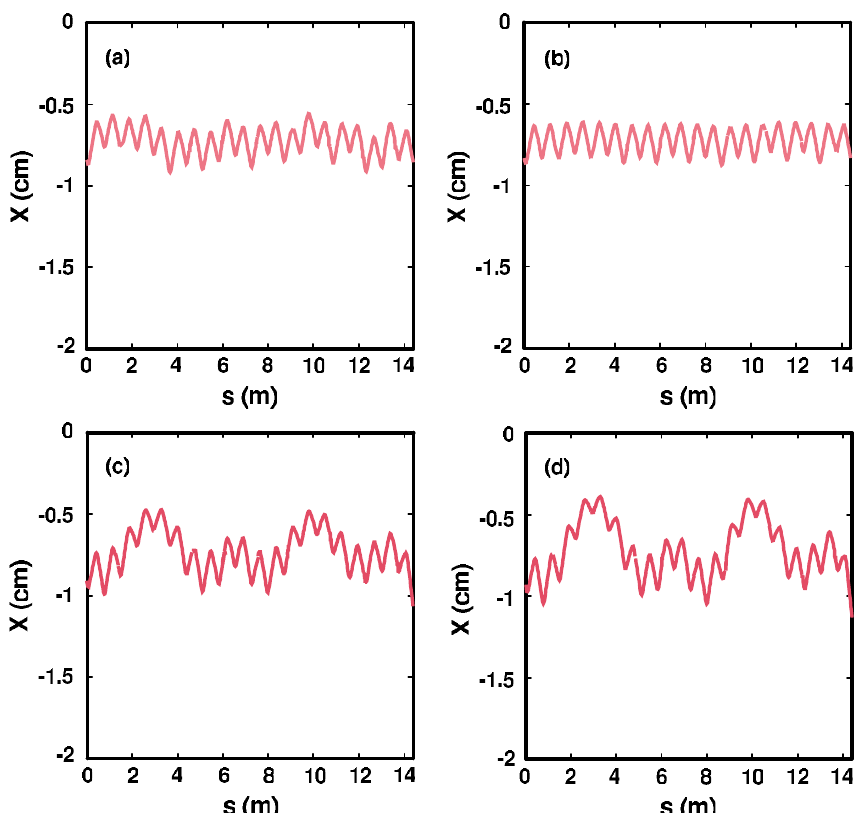
FIG. 7. (Color) Final-lap centroid histories showing the effects of applying a velocity tilt gradually in lattices with (a) 8, (b) 10, (c) 18, and (d) 34 cells per lap. Here, trapezoidal pulses are used for all waveforms, with the head-to-tail voltage increase adjusted to give the same overall